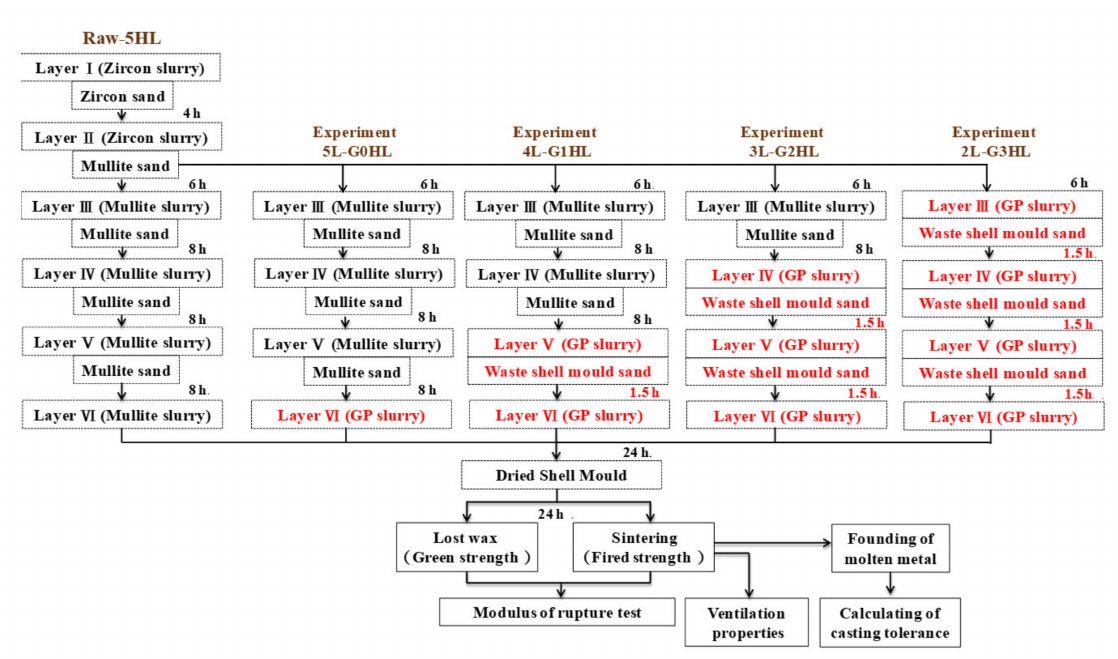
Figure 1. Experimental design of ceramic shell mould preparation (GP slurry: geopolymer